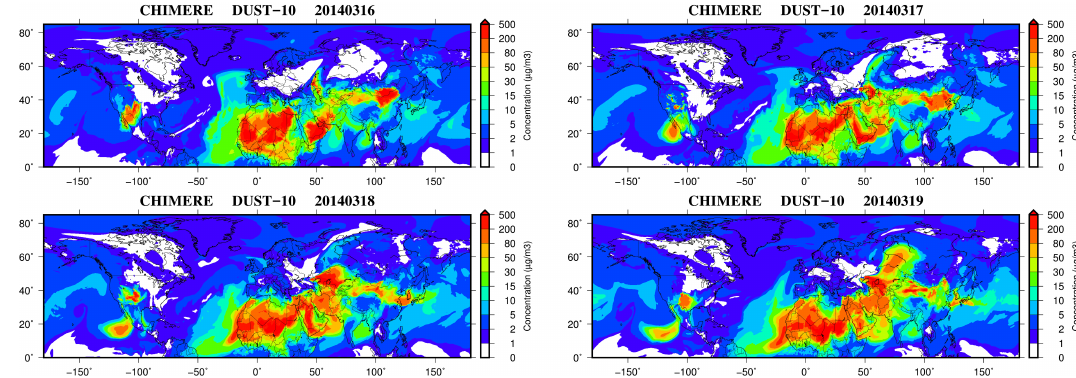
Figure 5. Daily surface dust concentrations simulated by CHIMERE for the 16–19 March 2014 period.